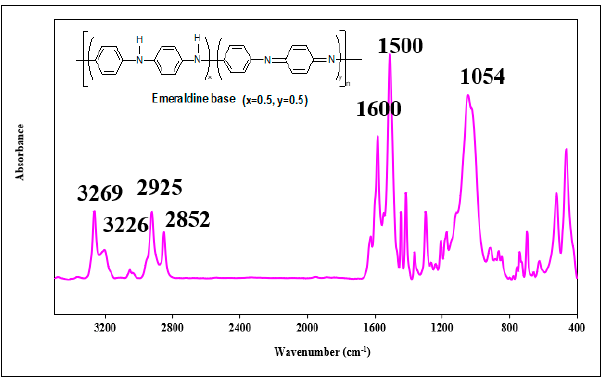
Figure 3. FTIR spectrum of PACN showing the characteristic peaks for clay and PANi.